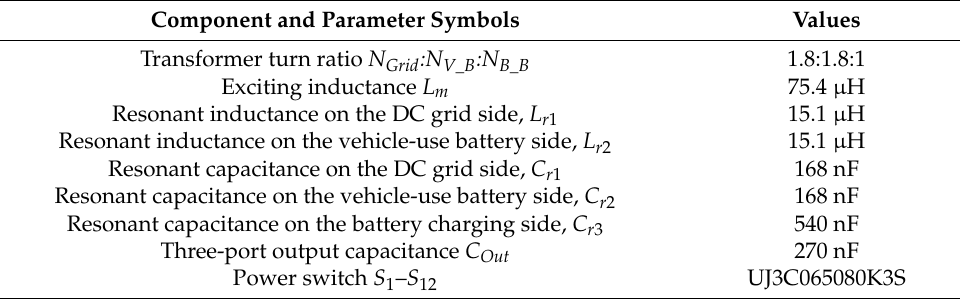
Table 4. Circuit parameters and components.